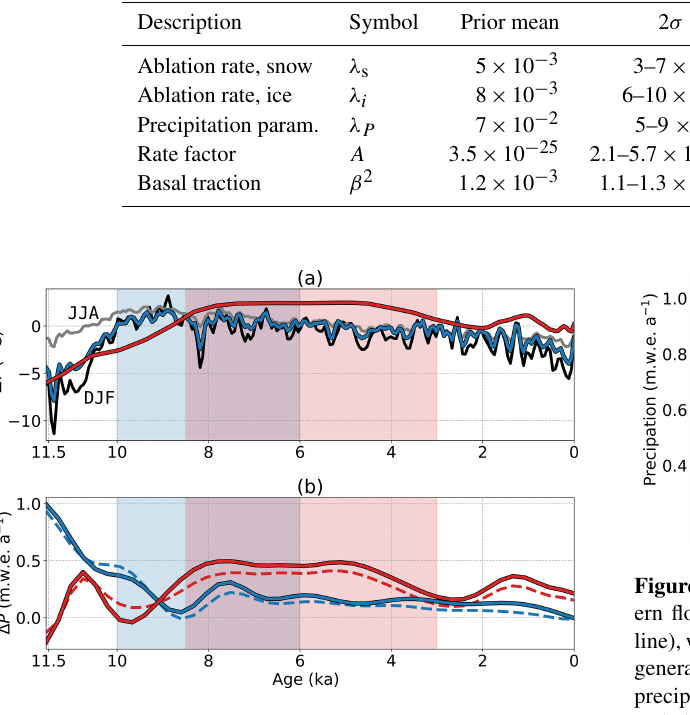
Figure 6. (a) Buizert et al. (2018) and Dahl-Jensen et al. (1998) mean annual temperature anomalies are shown as blue and red lines, respectively. Gray and black lines, respectively, show average December, January, February (DJF) and June, July, August (JJA) temperature anomalies for the Buizert et al. (2018) reconstruction. Shaded blue and pink regions demarcate the extent of the HTM for the Buizert et al. (2018) and Dahl-Jensen et al. (1998) reconstruc- tions. (b) Estimated precipitation anomaly histories for the Buizert et al. (2018) and Dahl-Jensen et al. (1998) inversions are shown by blue and red lines, respectively. Solid lines show estimates for the northern flow line, while dashed lines are for the southern flow line.